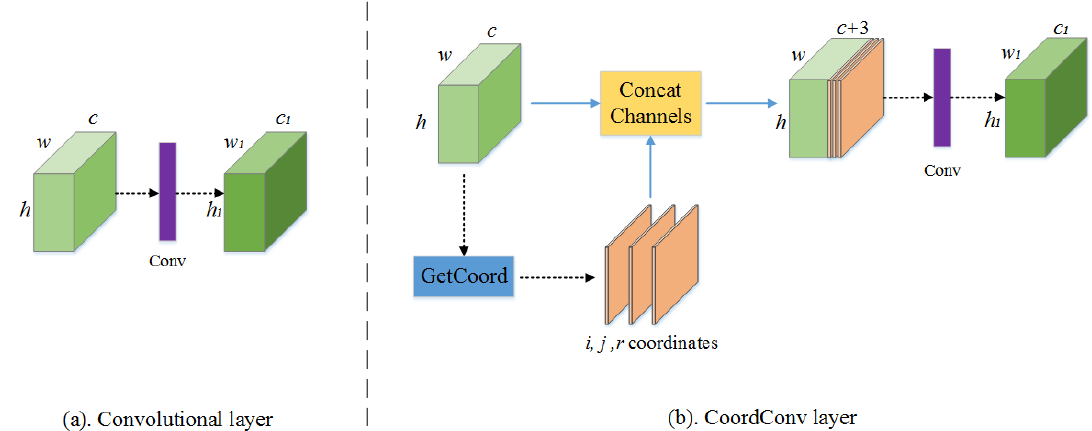
Figure 2. Comparison of the convolutional layer and coordconv layer. ( a ) A standard convolutional layer, where the input feature maps with shape h × w × c to new feature maps with shape h 1 × w 1 × c 1 . ( b ) A coordconv layer has the same input shape as the convolutional layer but first concatenates with extra channels from the incoming feature maps. Then, a standard convolutional layer is used.